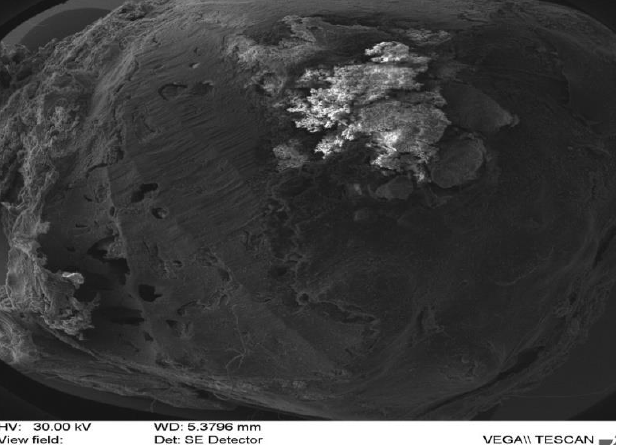
Figure 4. Excessive pre-osseous deposition in the form of agglomerations and smaller areas of less dense bone by phagocytic activity (MTA).